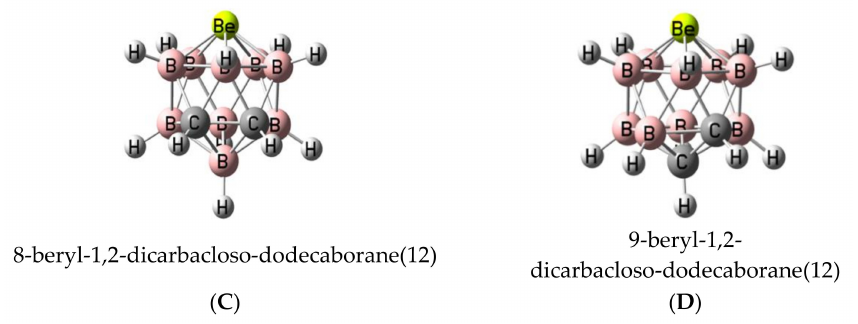
Figure 3. Optimized structure of the four B 9 H 11 C 2 Be isomers considered in this article with the